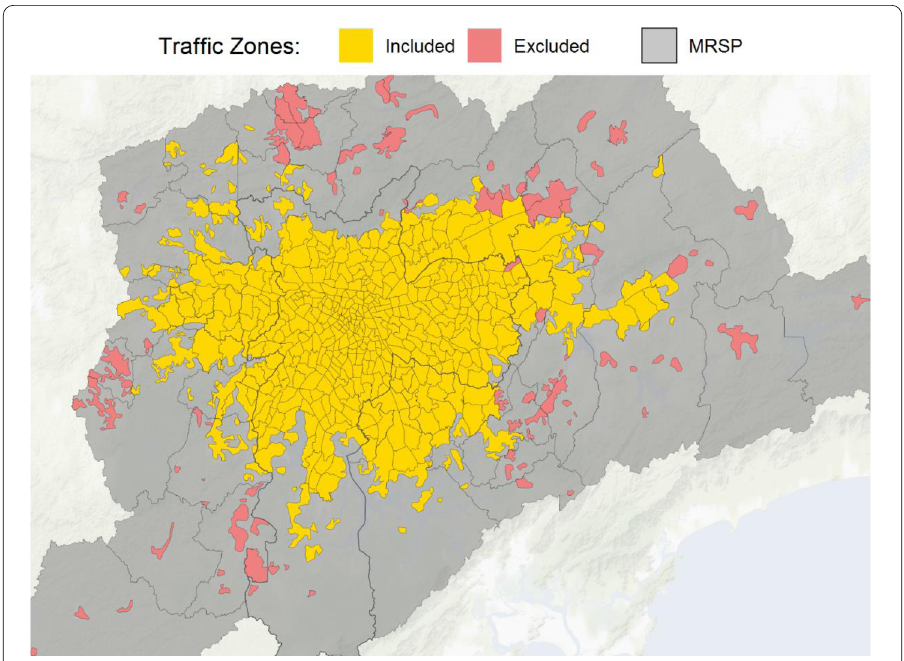
Figure 2 Traffic zones included in the selected pairs. Areas in yellow are urban traffic zones included in the traffic zone pairs used to construct the index. Areas in pink are urban traffic zones that are not included in the traffic zone pairs used in the index. The gray area corresponds to the non-urban parts of the Metropolitan Region of São Paulo